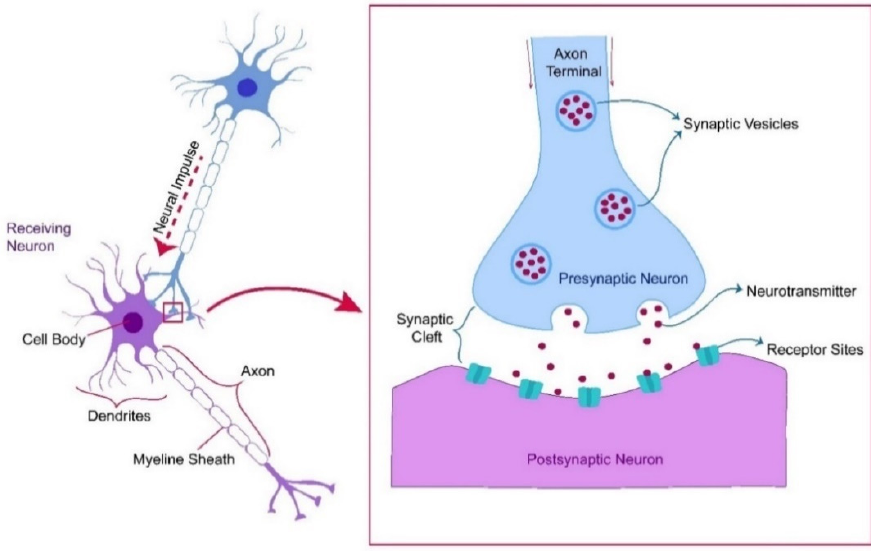
Figure 1. Synaptic transmission process.